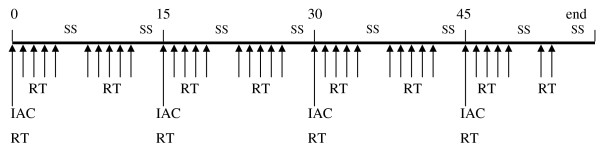
Timing of the treatment protocol. SS = Saturday, Sunday; RT = radiotherapy; IAC = intra-arterial chemotherapy.